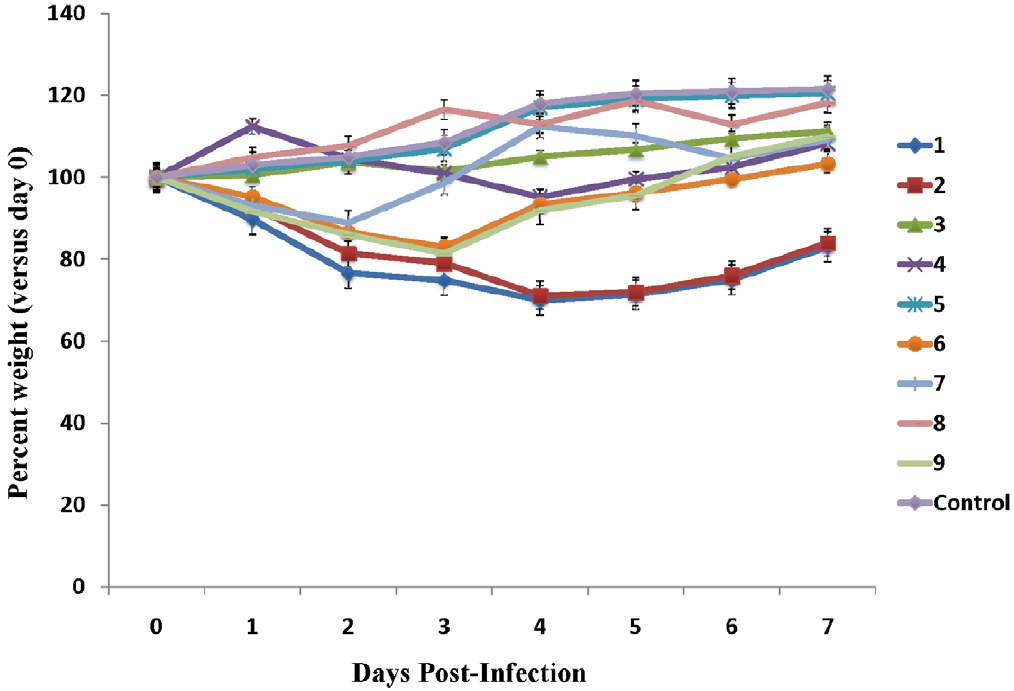
Figure 1. Weight loss in mice infected with APMV serotypes 1 to 9. Mice in groups of 6 were inoculated with allantoic fluid containing 2 7 HA units of each APMV serotype except serotype 5, which contained 3 6 10 3 PFU/ml of cell culture harvested virus. The control group was inoculated with normal allantoic fluid. The mice were weighed daily and weight lost was calculated as a percent of the weight on day 0. Data depict the mean 6 SD from 3 mice per group. doi:10.1371/journal.pone.0016776.g001 overlay. The tissue homogenates from APMV-5-infected mice respectively (Table 2). The mean virus titers from nasal turbinates were analyzed in parallel. Immunofluorescence staining for the N of the mice infected with APMV serotypes 1, 2, 3, 4, 6, 7, 8 and 9 protein 4 dpi revealed foci with strong positive intracellular were 3 6 10 1 , 6 6 , 2 6 10 1 , 1 6 10 2 , 3 6 10 2 , 1 6 10 1 , 2 6 10 2 and staining in the case of samples from the lungs and nasal turbinates 8 6 10 2 , respectively. These results indicated the titer of APMV for each of the APMV serotypes except APMV-5, for which no serotype 9 was higher than other serotypes in the lung and nasal virus was detected (Fig. 2). The mean virus titers from lungs of the turbinates, suggesting that it was the most permissive APMV for mice infected with APMV serotypes 1, 2, 3, 4, 6, 7, 8 and 9 were replication in mice. The brain tissue samples of APMV serotypes 2 6 10 2 , 3 6 10 2 , 7 6 10 1 , 2 6 10 2 , 2 6 10 2 , 3 6 10 1 , 5 6 10 2 and 9 6 10 2 , 4 and 9 infected mice that were positive for infection of Table 1. Virus isolation from the indicated tissue harvested from mice 3 dpi with APMV serotypes 1 to 9*.